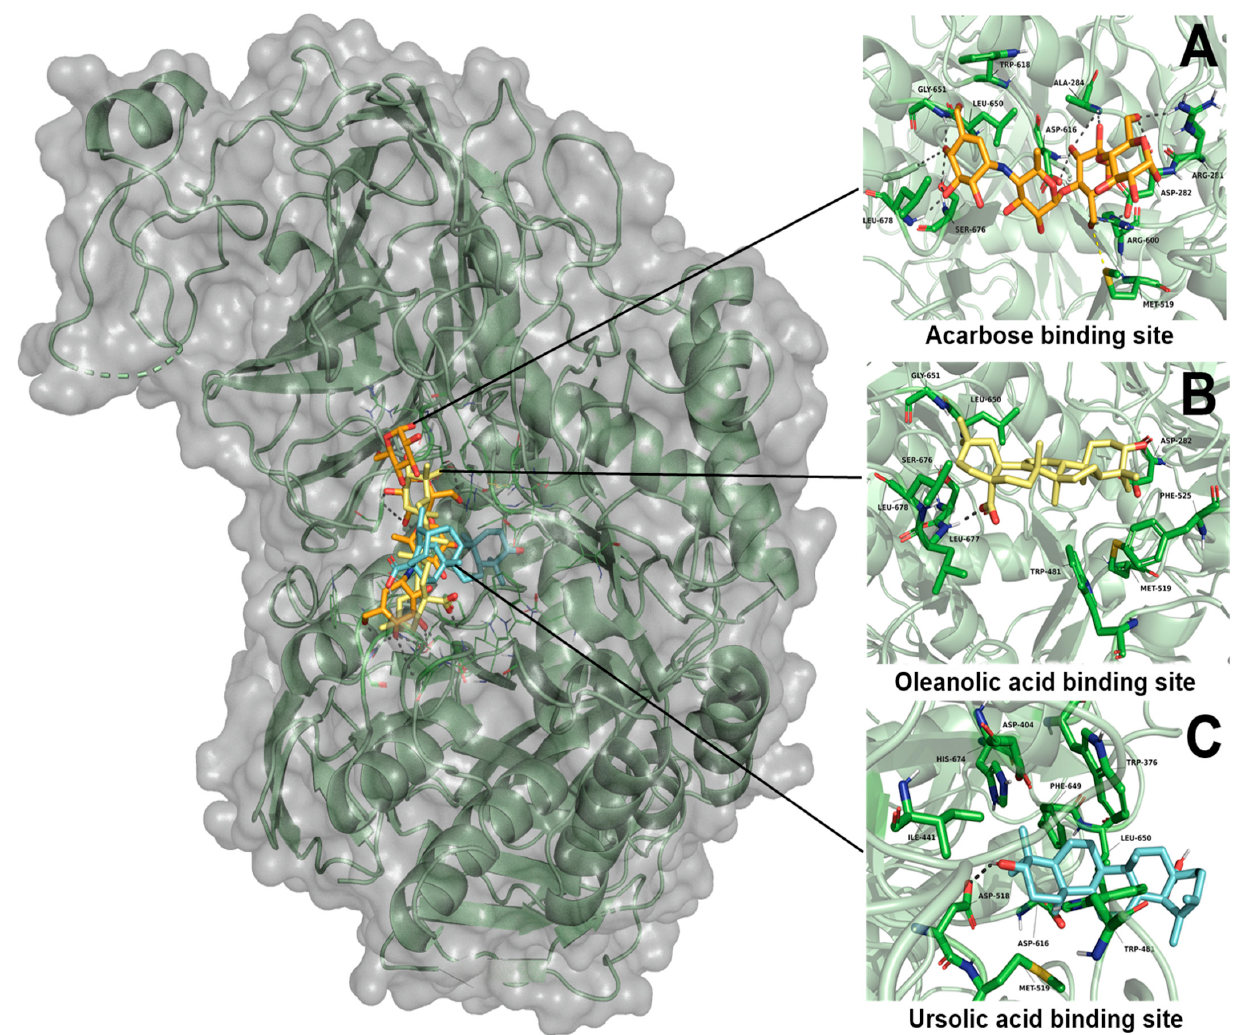
Figure 6. Results of molecular docking on α -glucosidase enzyme. ( A ) Interaction of acarbose and its binding site position; ( B ) interaction of oleanolic acid and its binding site position; ( C ) interaction of ursolic acid and its binding site